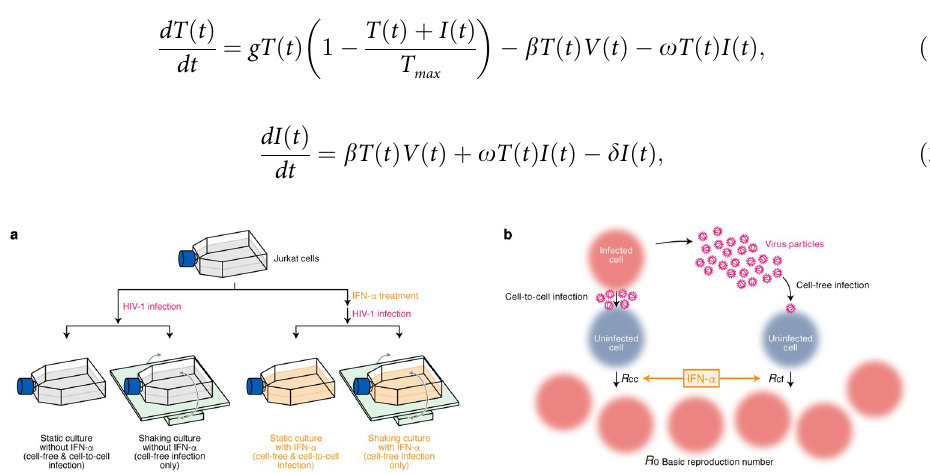
Fig 1. Cell culture systems and the basic reproduction number under cell-to-cell and cell-free infection with or without IFN- α . a An experimental scheme. Jurkat cells were infected with virus and cultured under four conditions: static or shaking cultures with or without IFN- α . IFN- α treatment (shown in orange) was performed at 24 h pre- infection. For the four cultures, the amount of viral particles in the culture supernatant and the numbers of infected and uninfected cells were routinely measured as described in Methods. The experimental results are shown in Fig 2 (for strain NL4-3), Fig 6 (for strain CH077_CC), and Fig 7 (for strain CH077_TF). b The basic reproduction number, R 0 , is defined as the number of secondarily infected cells produced from an infected cell during its infectious period. In the presence of the cell-to-cell and cell-free infection, the basic reproduction number consists of two sub-reproduction numbers in which cells are infected through cell-free infection, R , and through the cell-to-cell infection, R , cf cc